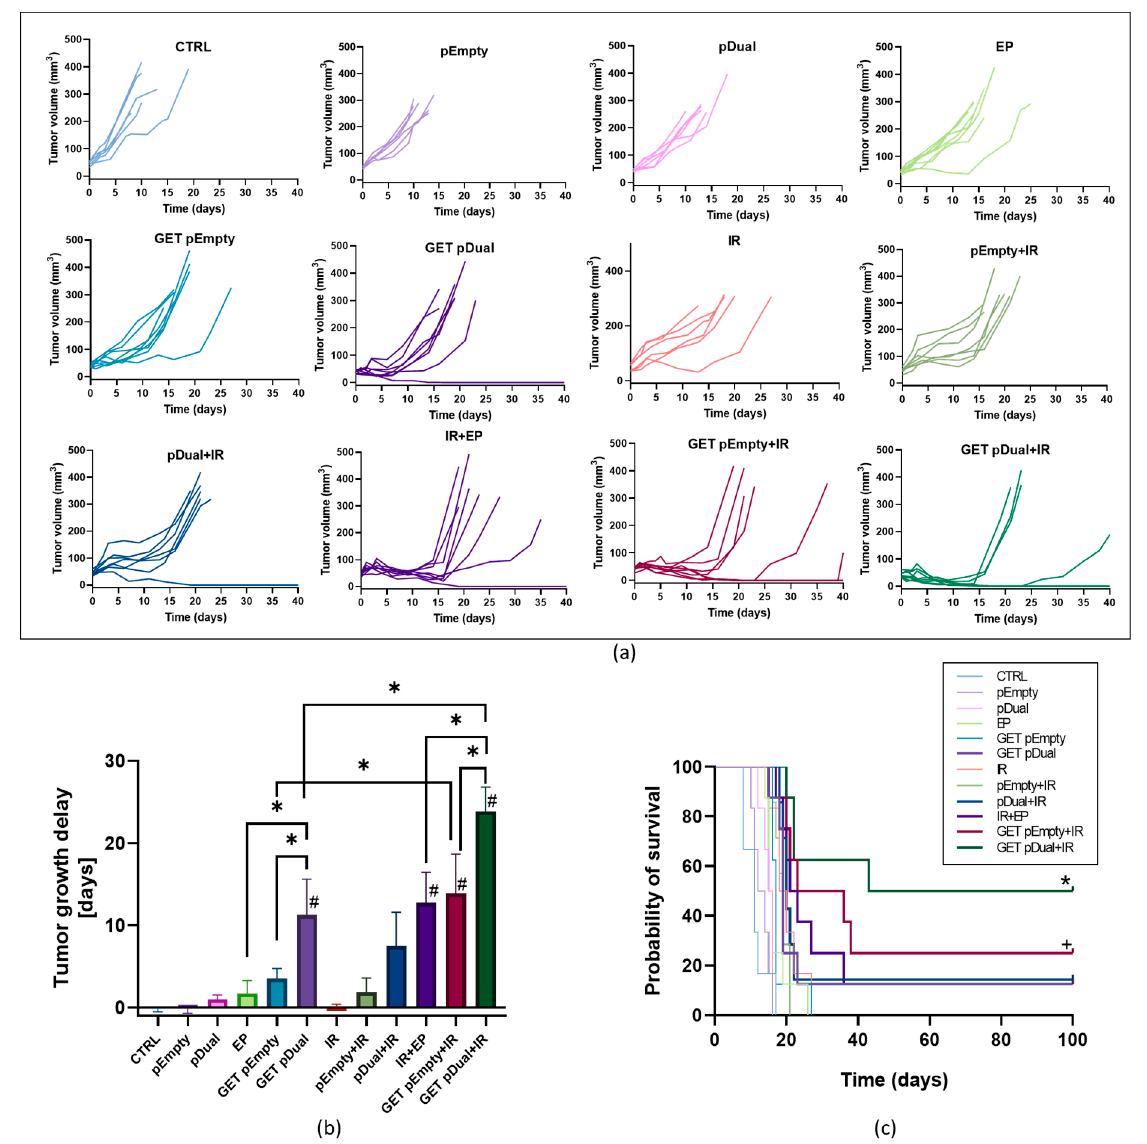
Figure 1. Therapeutic effectiveness in a murine mammary adenocarcinoma TS/A tumor model. ( a ) Individual tumor growth curves in all experimental groups. ( b ) Tumor growth delays in all experimental groups presented as the mean TGD with SEM. #, p < 0.05 vs. CTRL and IR; *, p < 0.05 vs. indicated group (only relevant comparisons are displayed: EP vs. GET pDual, EP vs. GET pEmpty, GET pEmpty vs. GET pDual, GET pEmpty vs. GET pEmpty + IR, GET pDual vs. GET pDual + IR, EP + IR vs. GET pEmpty, EP + IR vs. GET pDual, and GET pEmpty + IR vs. GET pDual + IR). ( c ) Kaplan–Meier survival curves with a tumor volume of 350 mm 3 counted as an event. *, p < 0.05 vs. all groups except pDual, EP + IR and GET pEmpty + IR; +, p < 0.05 vs. all groups except EP + IR, GET pDual and GET pDual + IR. n = 6–8 mice.